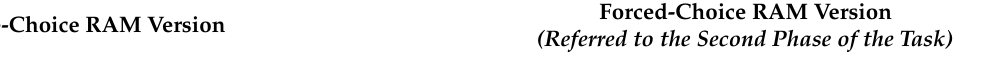
Table 3. Illustration of the main parameters used to analyze the performances in RAM